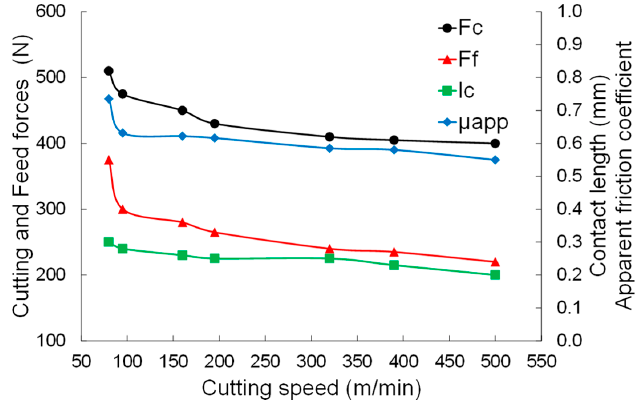
Figure 5. Experimental cutting force ( F c), feed force ( F f), contact length ( l c), and apparent friction coefficient ( μ app).